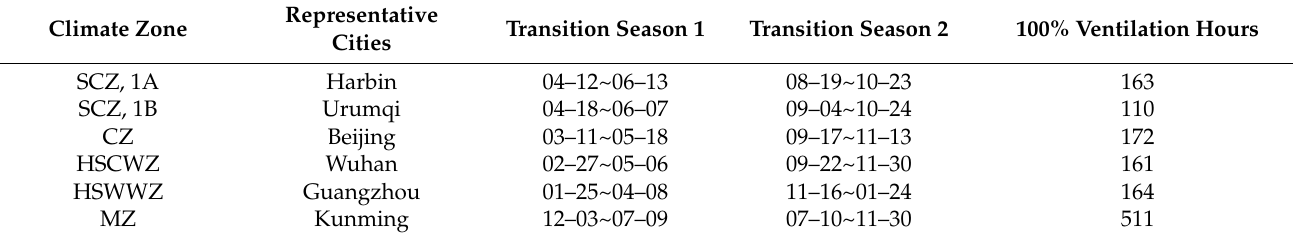
Table 4. Typical transition season of representative